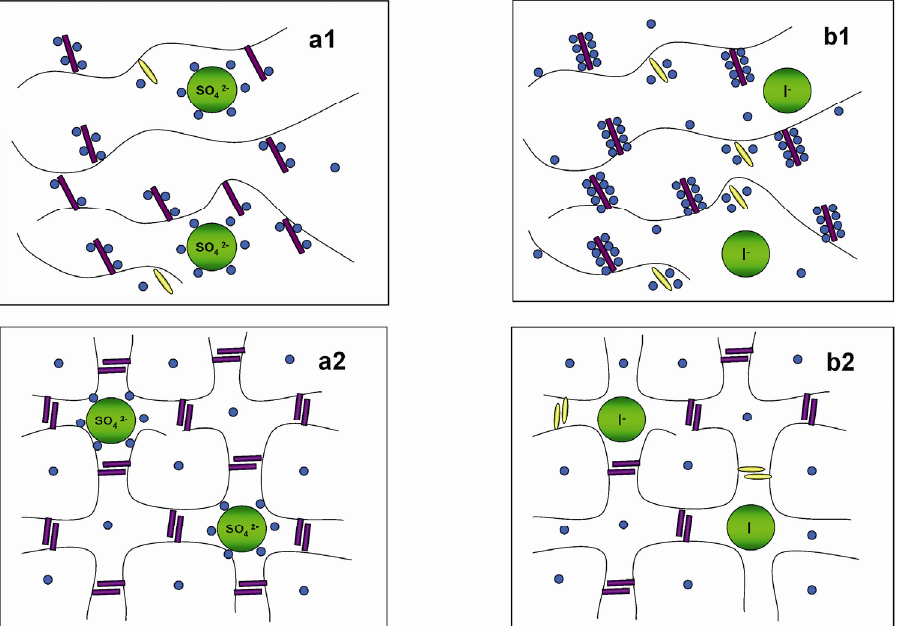
Figure 3. Physical structures of HPMC hydrogels in ( a ) 0.2 M Na NaI in H O (a1, b1 at lower temperatures and a2, b2 at higher 2